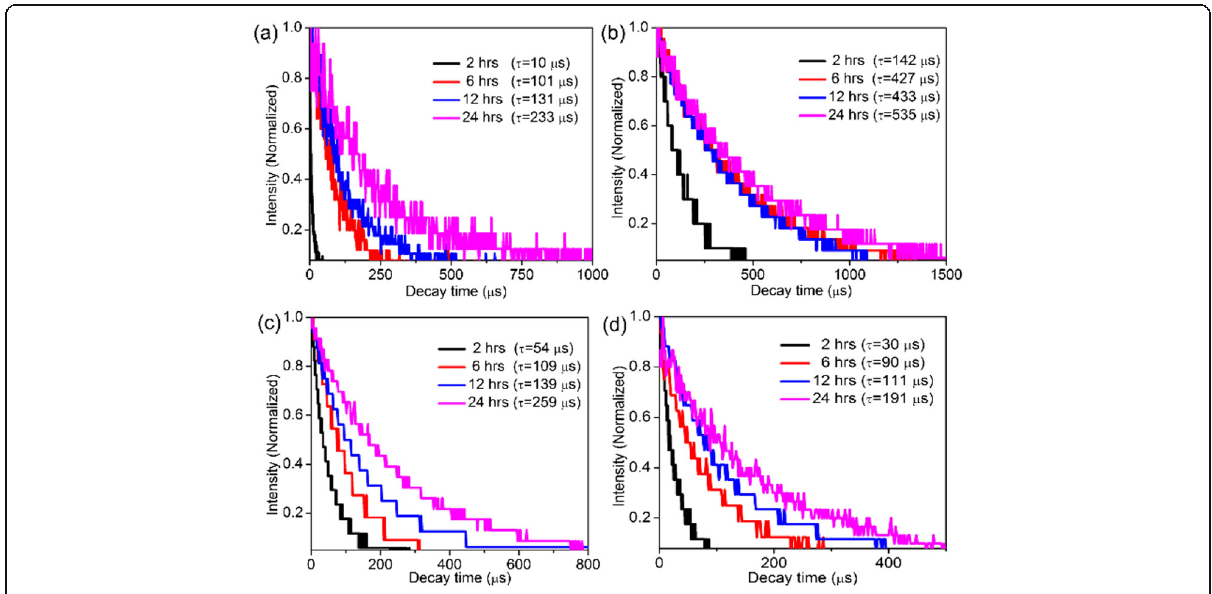
Fig. 8 Photoluminescence decay curves of the a 2 F 5/2 level of Yb 3+ , b 4 F 9/2 level of Er 3+ , c 4 F 9/2 level of Er 3+ , and d 2 H 9/2 level of Er 3+ in the heterogeneous core/shell α -NaGdF 4 / β -NaYF 4 :Yb, Er crystals with varied reaction time (black: 2 h, red: 6 h, blue: 12 h, pink: 24